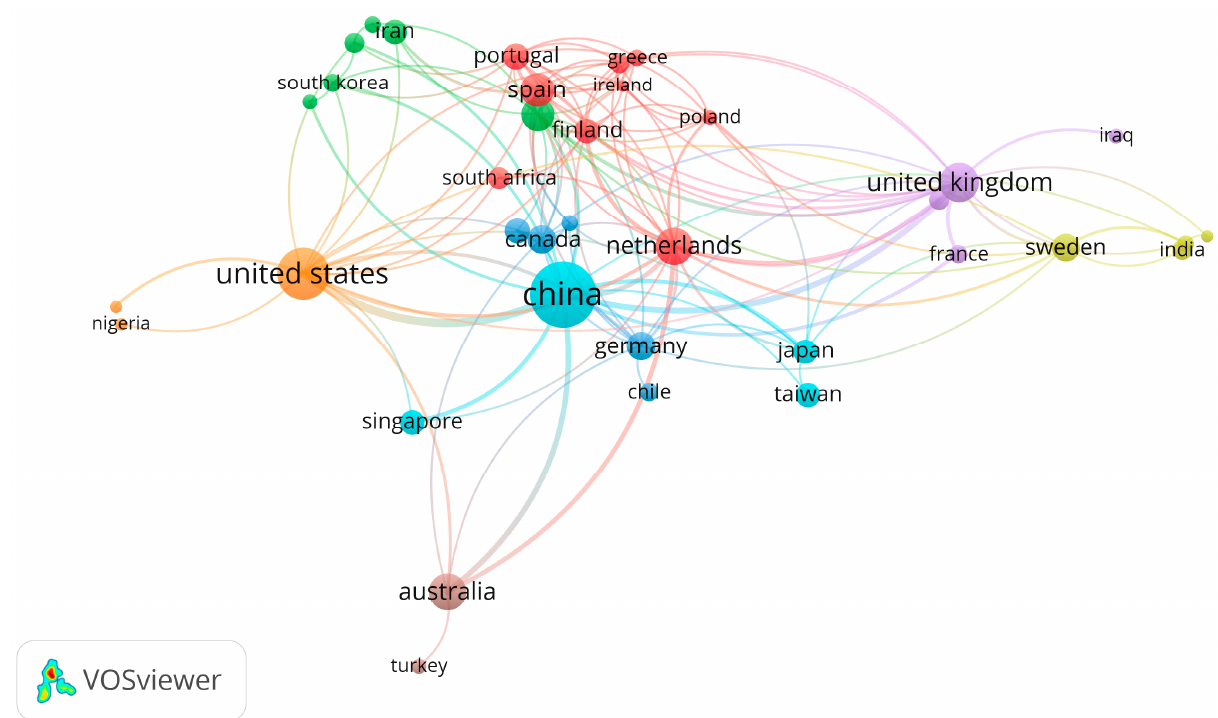
Figure 6. Country map (the node size is proportional to the number of publications).